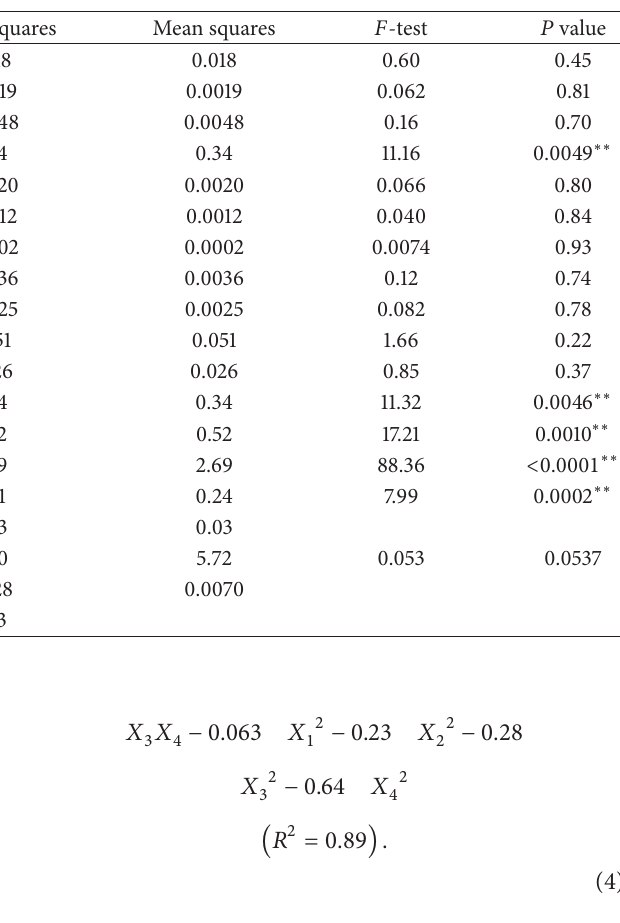
Table 3: The variance analysis and significance test table of regression coefficient of response surface